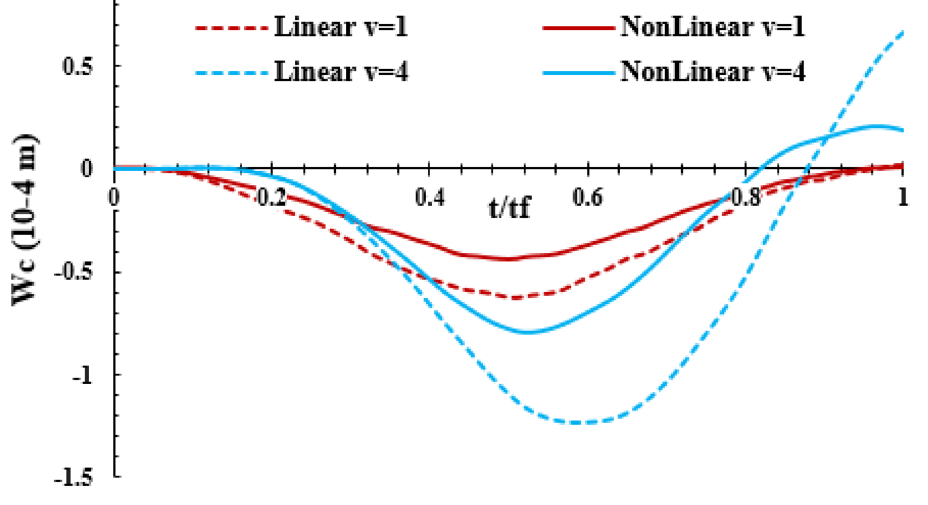
Fig. 10 The effect of velocity of moving force on deflection history of center-point of the plate (SSSC boundary condi-